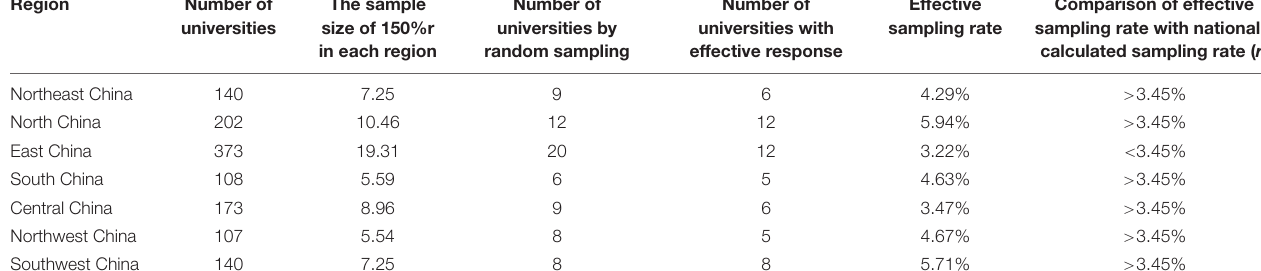
TABLE 1 | Number of universities in different regions and their sampling numbers.